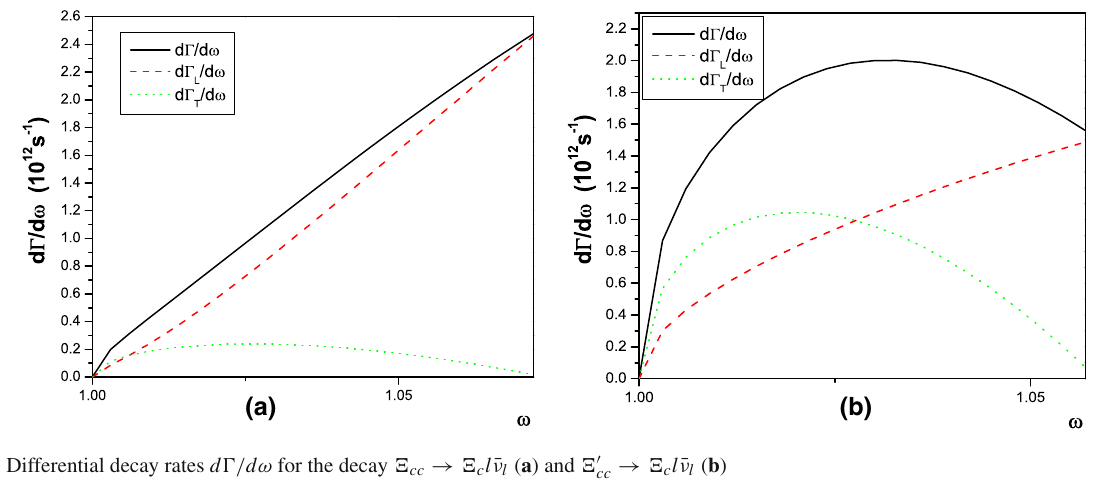
Fig. 4 Differential decay rates d (cid:16)/ d ω for the decay (cid:2) cc → (cid:2) c l ¯ ν l ( a ) and (cid:2) (cid:3) cc → (cid:2) c l ¯ ν l ( b )